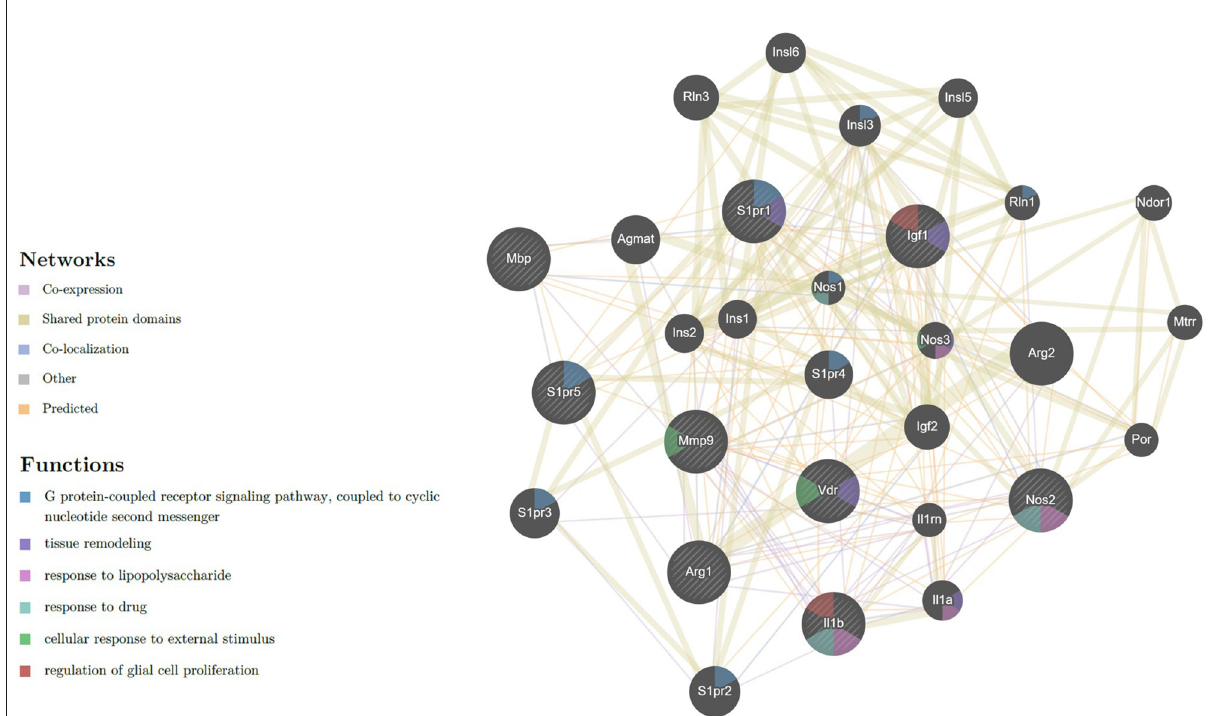
FIGURE7 Network of expressed genes that related to M1/M2 microglia phenotype and myelination with receptors of Vit D3 and Sipo. VDR, MBP, S1PR5, S1PR1, MMP-9, Arg-1, IGF-1, iNOS, IL-1 β , showing 20 related genes and 239 total links. VDR, vitamin D (1,25-dihydroxyvitamin D3) receptor; MBP, myelin basic protein; S1PR5, sphingosine-1-phosphate receptor 5; S1PR1, sphingosine-1-phosphate receptor 1; MMP9, matrix metallopeptidase 9; Arg1, arginase; IGF1, insulin-like growth factor 1; iNOS, inducible nitric oxide synthase; IL-1 β , interleukin 1 beta; Arg2, arginase type II; S1PR2, sphingosine-1-phosphate receptor 2; S1PR3, sphingosine-1-phosphate receptor 3; Agmat, agmatine ureohydrolase; S1PR4, sphingosine-1- phosphate receptor 4; Rln3, relaxin 3; IGF-2, insulin-like growth factor 2; Insl3, insulin-like 3; Il1a, interleukin 1 alpha; Insl6, insulin-like 6; Insl5, insulin-like 5; Ins2, insulin II; Ins1, insulin I; Nos3, nitric oxide synthase 3, endothelial cell, Ndor1, NADPH dependent diflavin oxidoreductase 1; Mtrr, 5-methyltetrahydrofolate-homocysteine methyltransferase reductase; Rln1, relaxin 1; Il1rn, interleukin 1 receptor antagonist; Por, P450 (cytochrome) oxidoreductase; Nos1, nitric oxide synthase 1, neuronal. The nature of the identified interaction was indicated by the color of the line as seen in